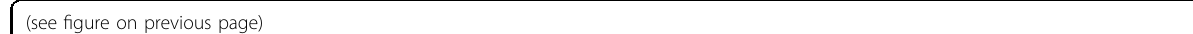
Fig. 3 tPARP1 recognizes the Pol III complex during apoptosis. a The cleavage of PARP1 was examined in a time course in poly(dA-dT)- stimulated (3 μ g/mL) apoptotic U2OS cells with anti-PARP1 N-terminus (PARP1) or C-terminus (tPARP1) antibody. b Apoptosis induced by 5 μ g/mL of poly(dA-dT) in U2OS cells was determined by Annexin V-FITC/PI double staining. c Morphology change of apoptotic U2OS cells stimulated by 5 μ g/ mL poly(dA-dT) was recorded every 3 h for a total of 12 h. Scale bar, 50 μ m. d mPARP1 was expressed in U2OS PARP1-null cells, followed by 5 μ g/mL poly(dA-dT) induction for 6 h. mtPARP1 but not mPARP1 interacted with endogenous POLR3A, POLR3B, or POLR3F. Data are represented as means ± SD as indicated from three independent experiments. Signi fi cance of differences was evaluated by Student ’ s t -test. ** P < 0.01; *** P <